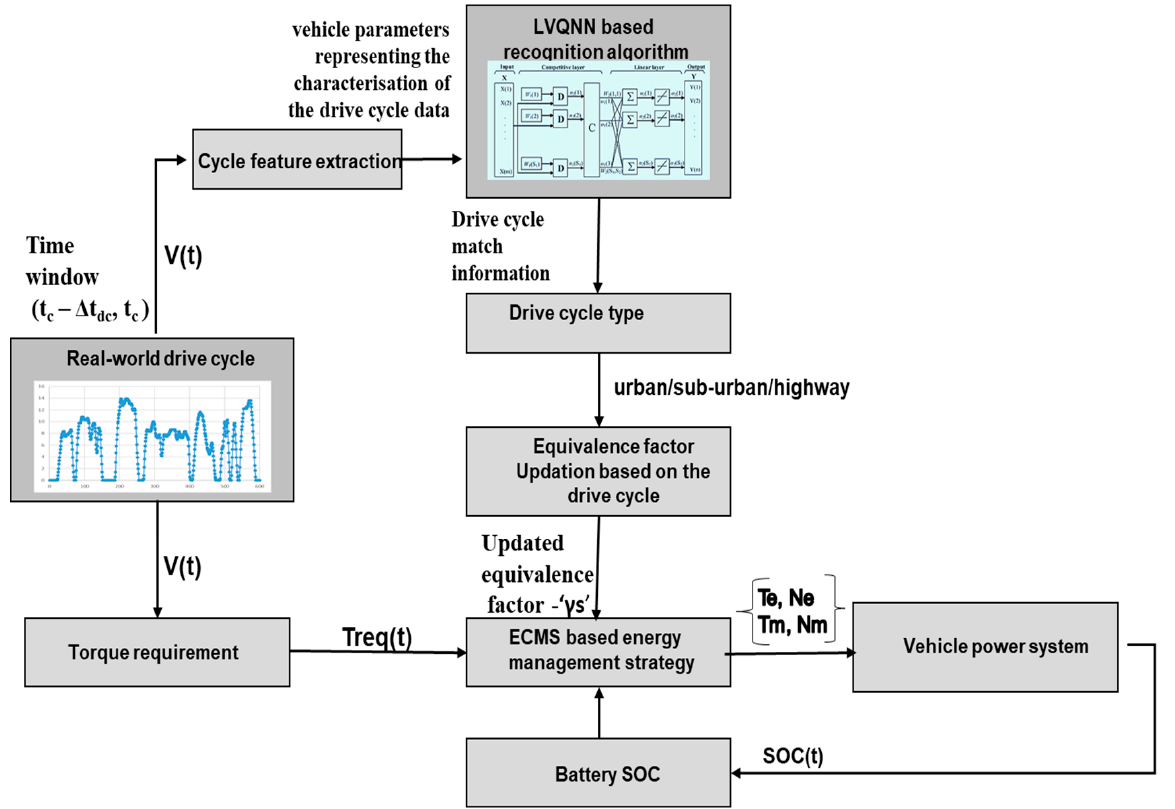
Figure 4. The control flowchart of adaptive ECMS (A-ECMS).